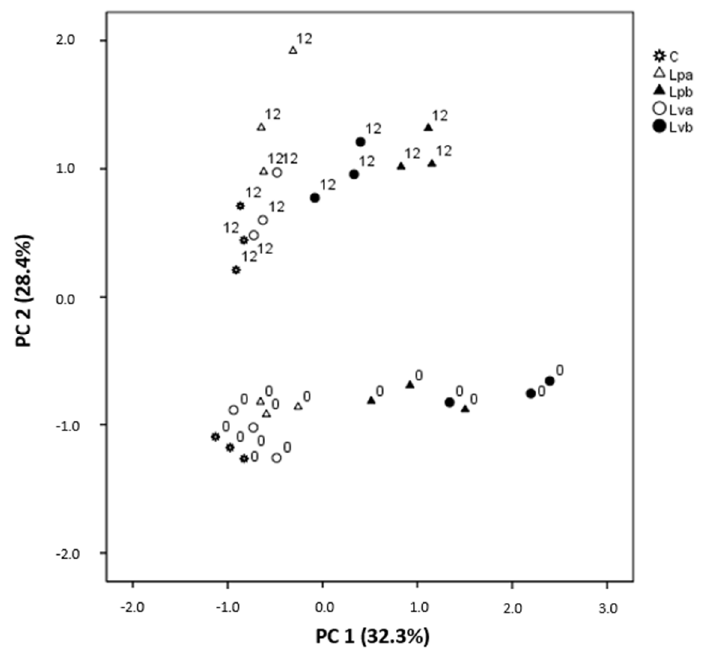
Figure 3. Distribution of deer burgers during chilled storage in the space defined by the first two Principal Components (PC1 and PC2). The selected variable was the volatile composition analyzed by SPME-GC-MS. C: sodium ascorbate control; Lva: 2.5% “verdejo” lees; Lvb: 5% “verdejo” lees; Lpa: 2.5% “palomino” lees; Lpb: 5% “palomino” lees.